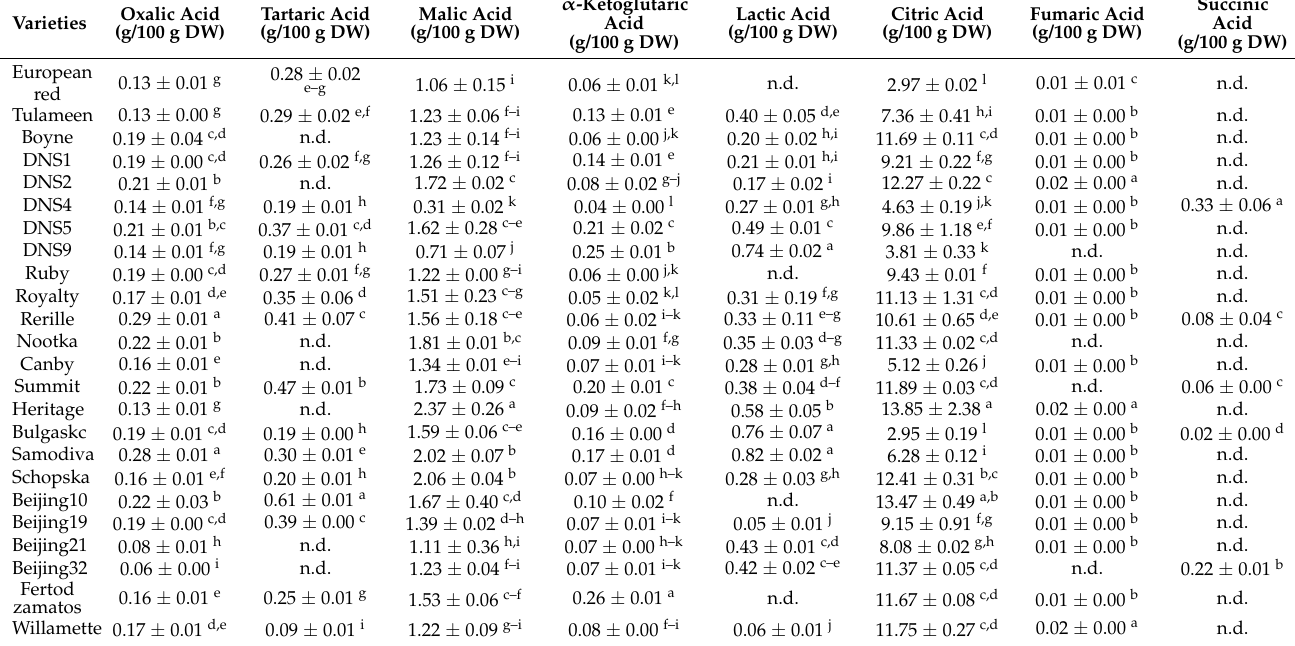
Table 4. Organic acid contents of 24 red raspberry